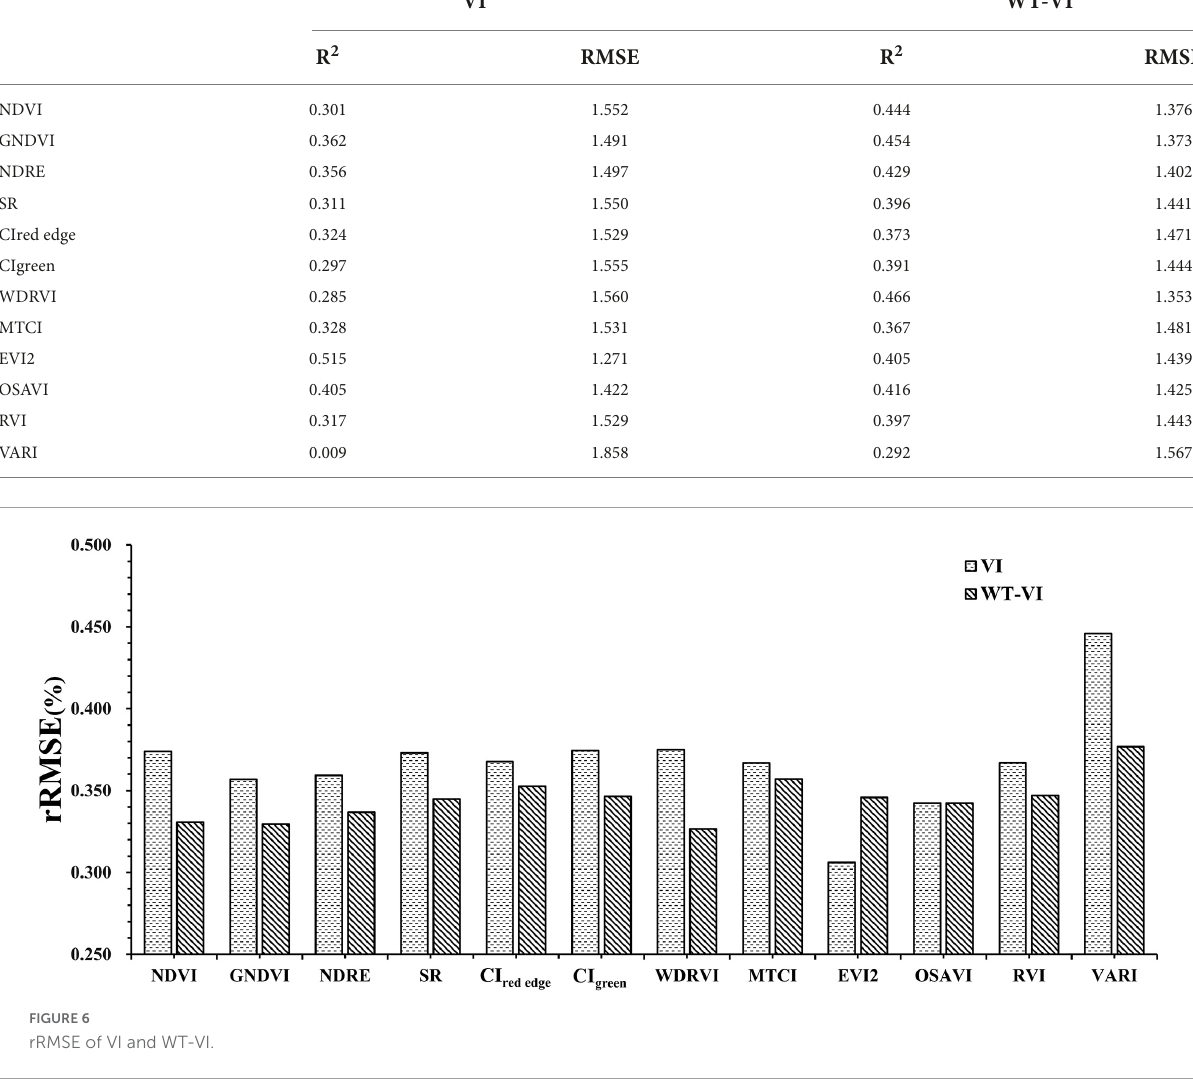
TABLE 5 Comparison of the accuracy of VI and WT-VI models using 10-fold cross-validation.